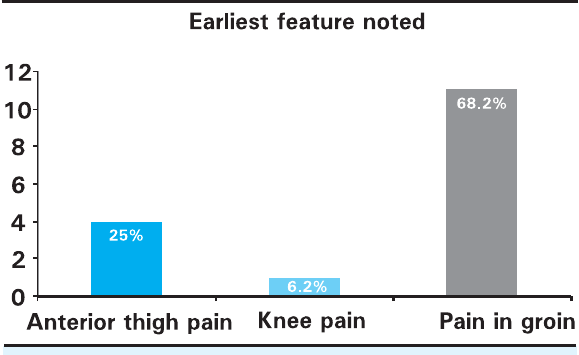
Figure 1. Earliest signs of femoral neck stress fracture Figure 1. Weeks of